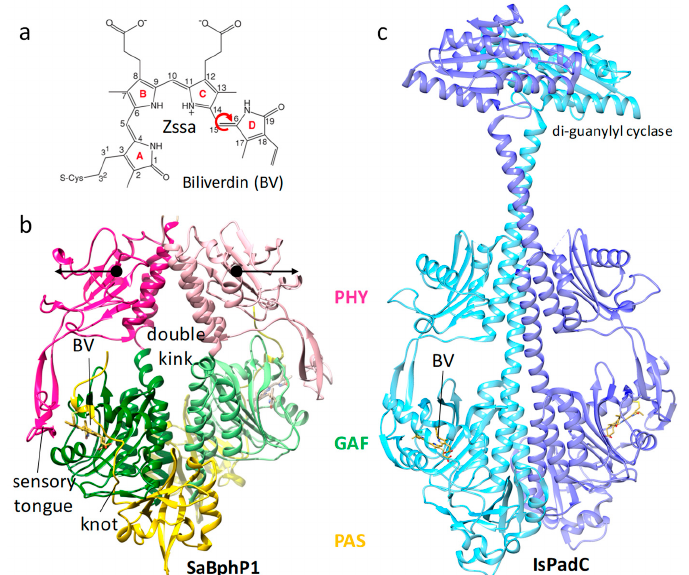
Figure 7. Bacterial phytochrome structures. ( a ) Structure of the central chromophore, biliverdin (BV). In dark-adapted BphPs, biliverdin (BV) is found in most cases in the Z syn–syn–anti configuration. Red arrow: isomerization upon red light absorption. ( b ) Structure of the myxobacterial phytochrome 1 (SaBphP1) photosensory core module; PDB entry 6BAO [32]. PAS, GAF, and PHY domains are colored yellow, green, and magenta, respectively. The sensory tongue, the knot, and the BV are marked. Black arrows: structural displacements of the PHY domains after light absorption; PDB entry 6BAO. ( c ) Structure of the full-length Idiomarina spp. phytochrome-activated diguanylyl cyclase (IsPadC), pdb entry 5LLW